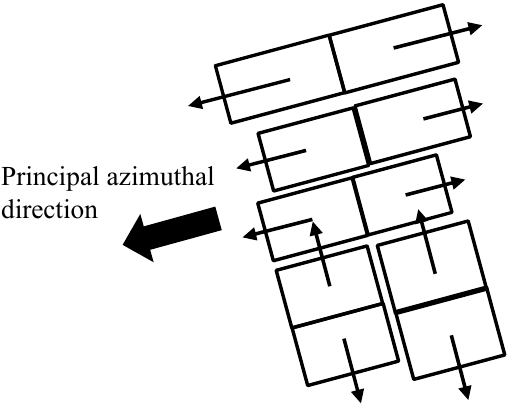
Figure 3. Determination of principal azimuthal direction of a point